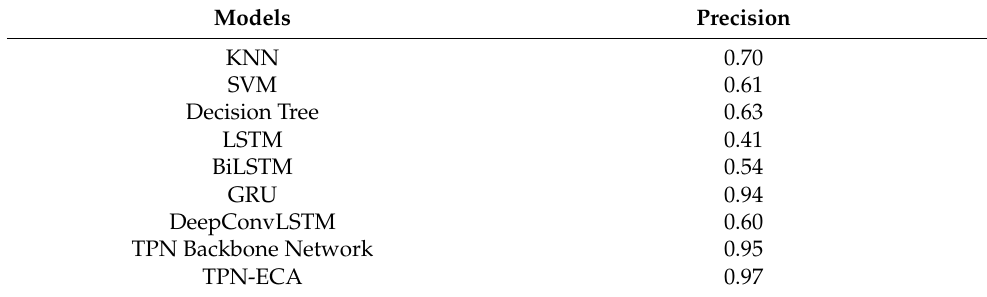
Table 5. Activity classification precision of all experimental